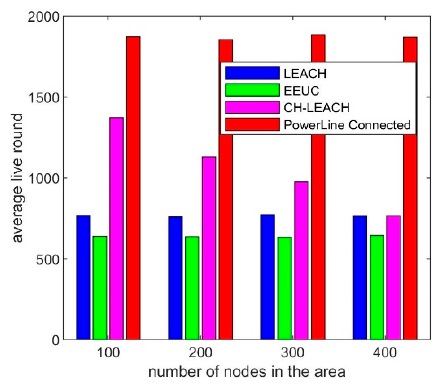
Figure 9. Simulation result, Network lifetime comparison at different node density.